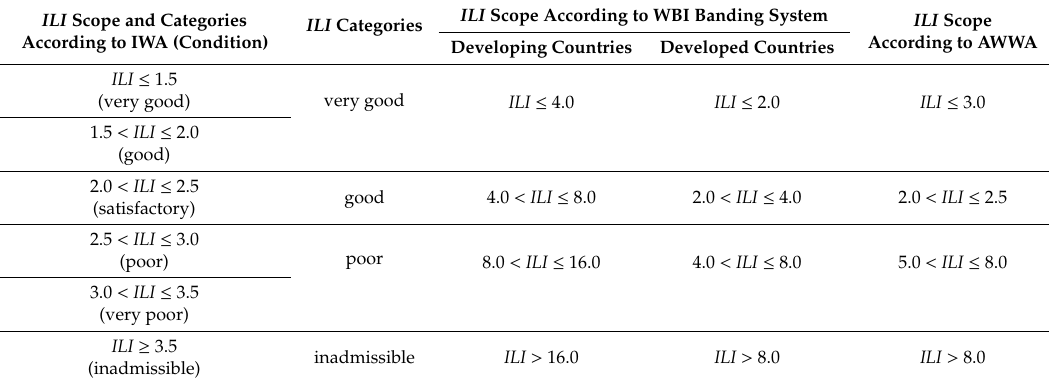
Table 5. Categories of assessment of water supply systems according to ILI [31].